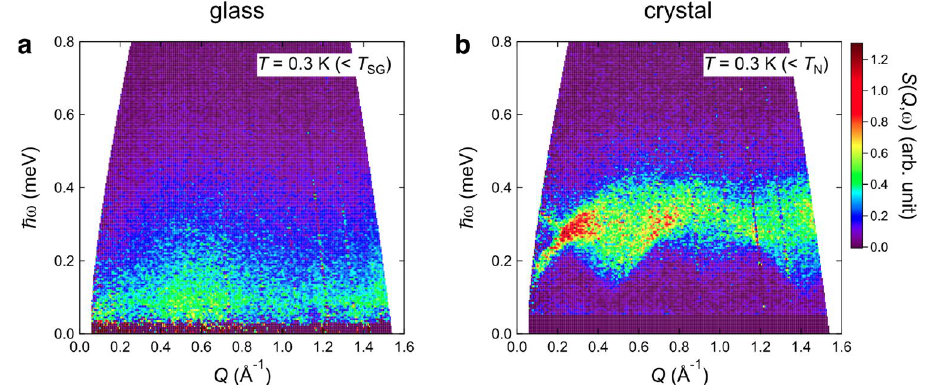
Figure 3. Magnetic excitations of C4mimFeCl 4 . ( a , b ) Energy (ℏω)-momentum ( Q ) maps of scattering intensities of ( a ) glass and ( b ) crystal states at T = 0.3 K.